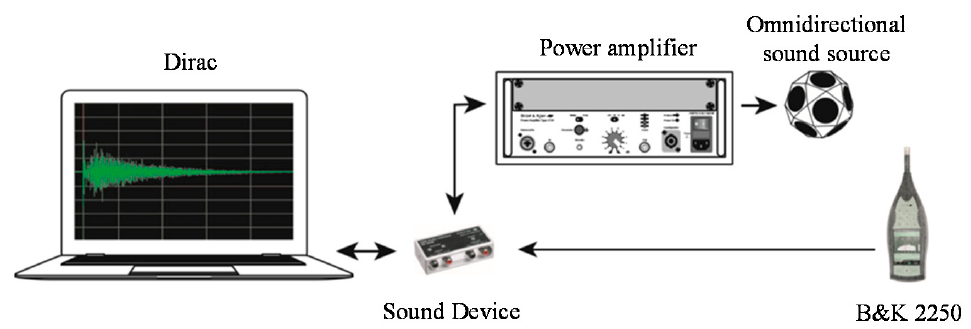
Figure 12. System of the field measurement.